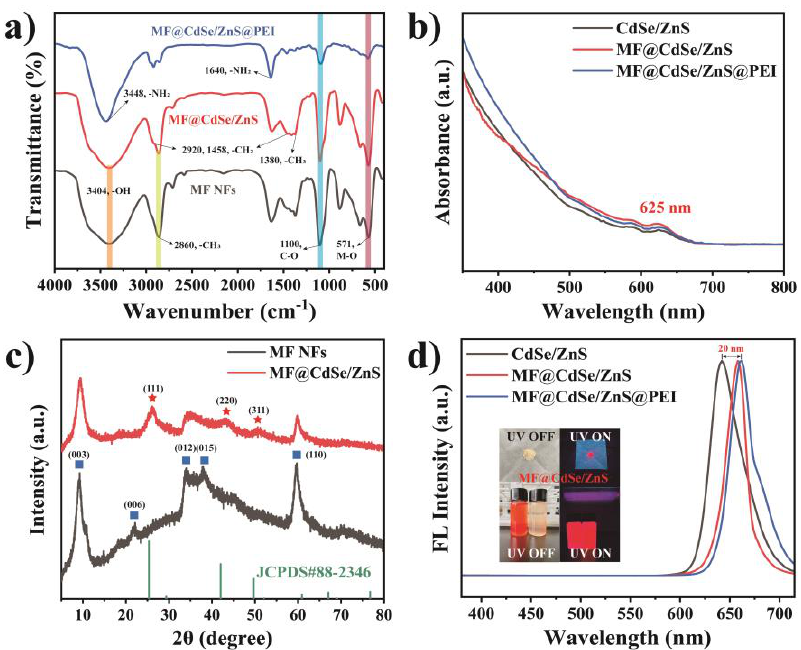
Figure 3. ( a ) Fourier transform-infrared spectra of Mg/Fe LDH NFs, MF@CdSe/ZnS NFs, and